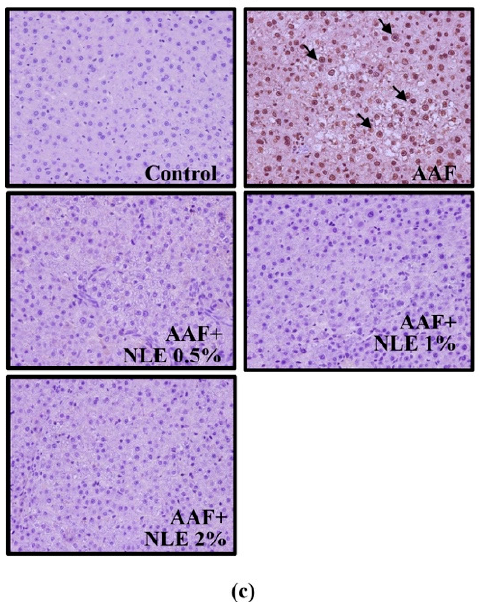
Figure 6. E ff ect of NLE supplementation on oxidative stress induced by AAF in the rat liver. ( a ) Levels